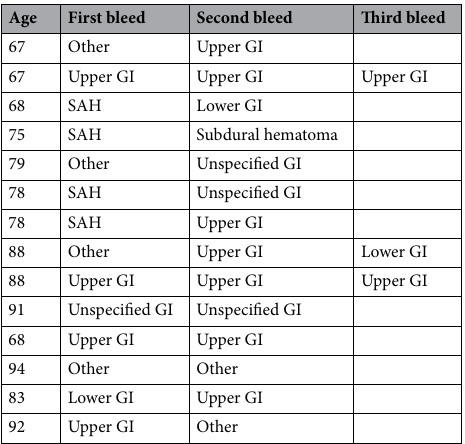
Table 2. Fourteen patients with more than one bleeding episode, with bleeding localization presented in order of events. GI gastrointestinal, SAH subarachnoid hemorrhage, other includes intraocular, retroperitoneal, and urinary tract bleeding.